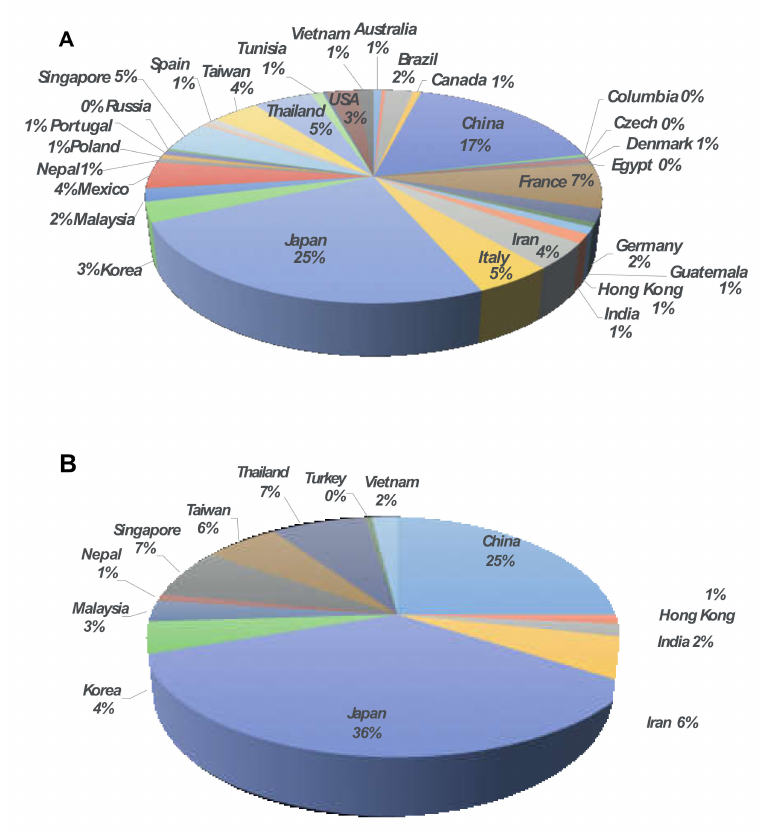
Figure 1. Distribution of IMP-type metallo- β -lactamase annotated genes ( A ) worldwide ( B ) in Asia.